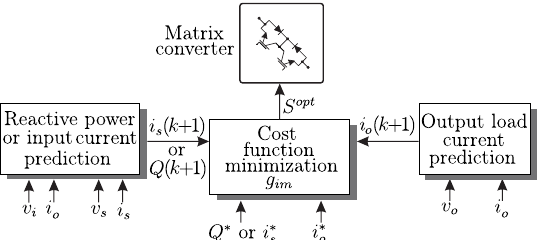
Figure 8. Predictive current control with input resonances mitigation block diagram.